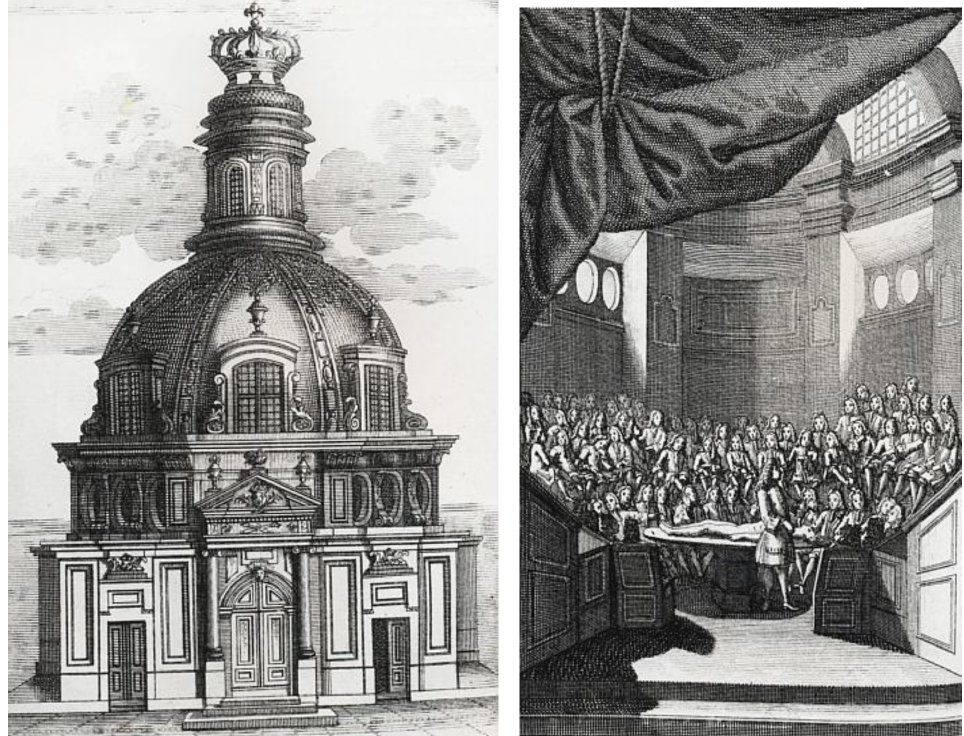
Fig. 1. Built by the architect Joubert, the prestigious anatomy theater of St Côme (5, rue de l'École de Médecine in Paris), the fi rst seat of the Academy, is today the Sorbonne ’ s language